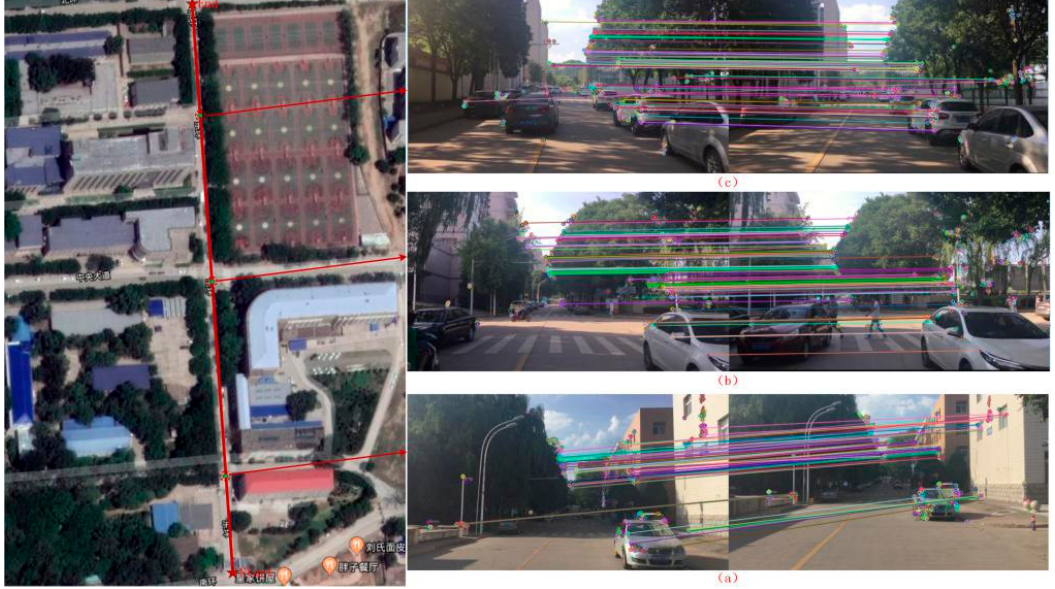
Figure 10. Place nodes of image matching.